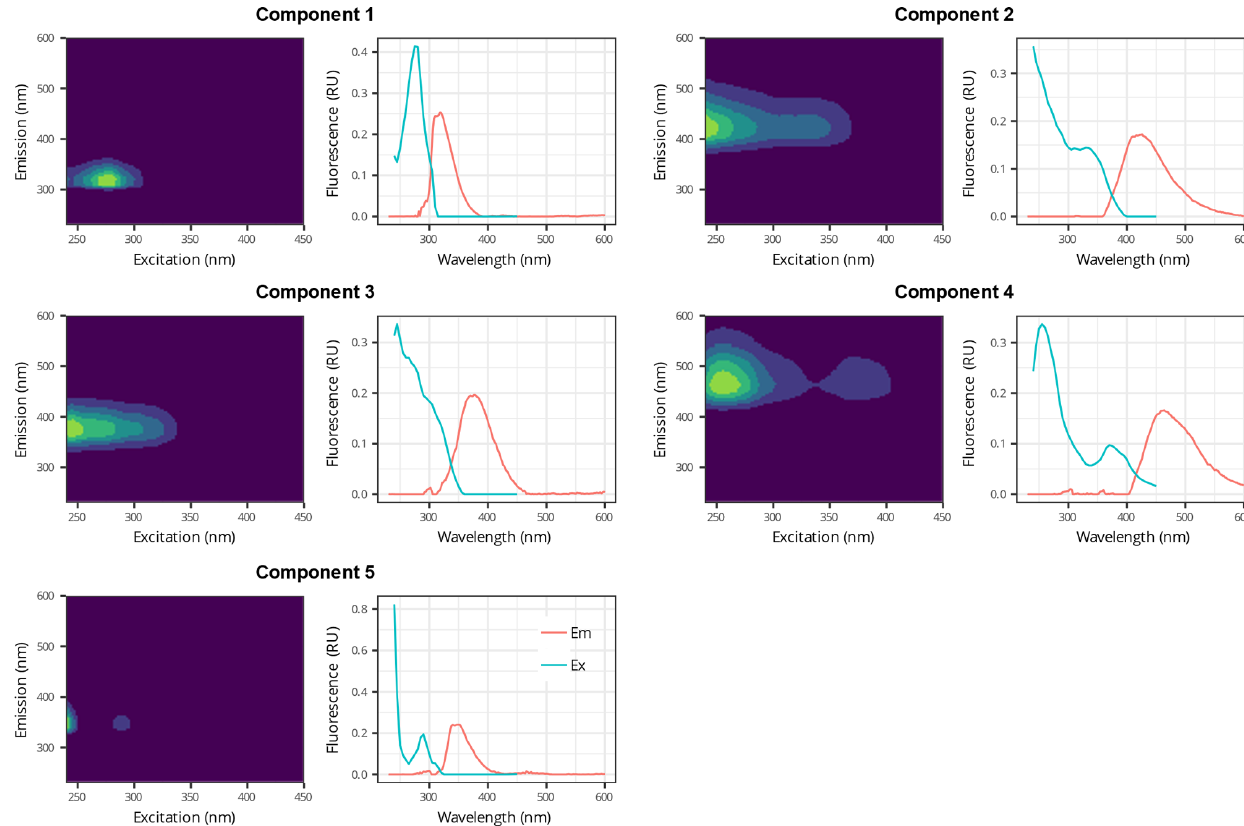
Figure 2. Excitation–emission contours of five components identified by PARAFAC modeling (left panels) and split-half validations of excitation and emission loadings (right panels). Excitation/emission maximum wavelengths are: C1: 275/320nm; C2: < 240(335)/426nm; C3: 245/378nm; C4: 255(370)/464nm; C5: <